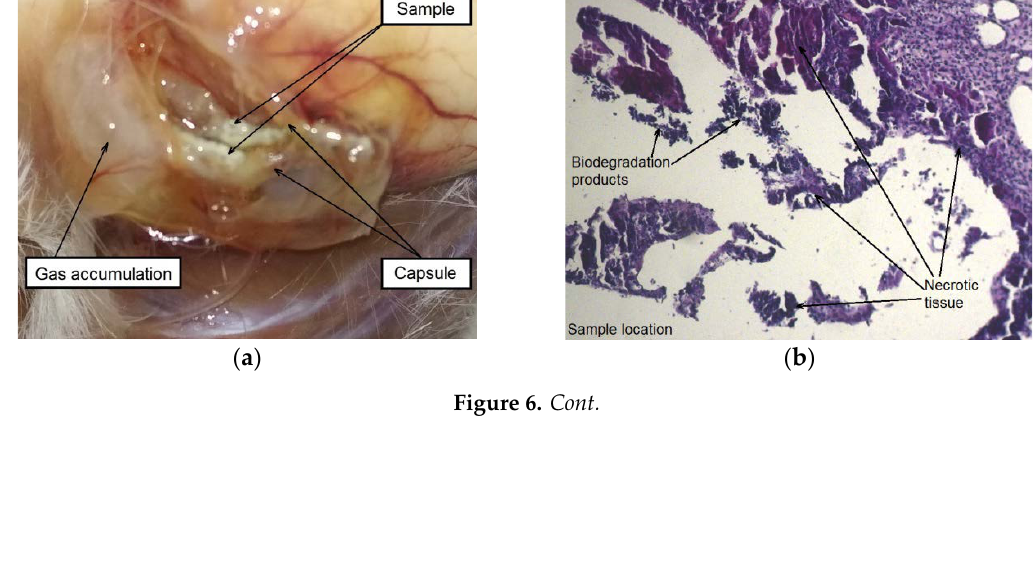
( f ) Figure 6. The sample of alloy WE43 in the initial state and the area around the implant two weeks after surgery: fragments of the sample inside the capsule, swelling and accumulation of gases in the surrounding tissue ( a ), results of histological examination of mouse tissues (hematoxylin – eosin (HE) staining) in the area of contact with the samples, showing the formation of large gas cavities, the expansion of blood vessels, the accumulation of biodegradation products, leucocyte infiltration, and contact tissue necrosis ( b–f ). The autopsy results for a group of animals with an implanted alloy WE43 in the UFG state also showed the formation of a capsule around an implant. However, there were no signs of local edema or increased blood flow in this area. No presence of dilated blood vessels, hemorrhages, and gas accumulation was also detected. A histological examination of tissues in the area of contact with the MAD-treated UFG alloy sample showed that a large part of the sample was surrounded by a thin- walled capsule without signs of general cellular infiltration. It can be concluded that the process of biodegradation of the sample for the period (two weeks) occurred mainly at its corners. This is supported by the observed localized thickening of the capsule with the attraction of leucocytes near